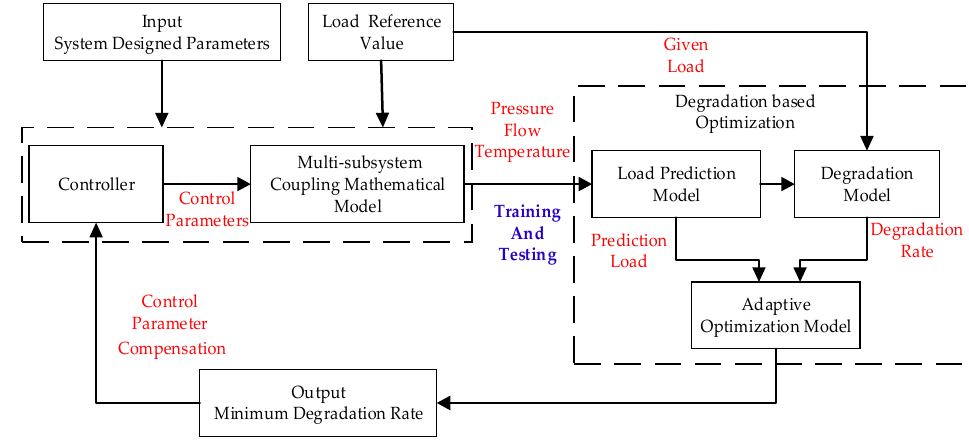
Figure 1. Proposed framework for compensation optimization.